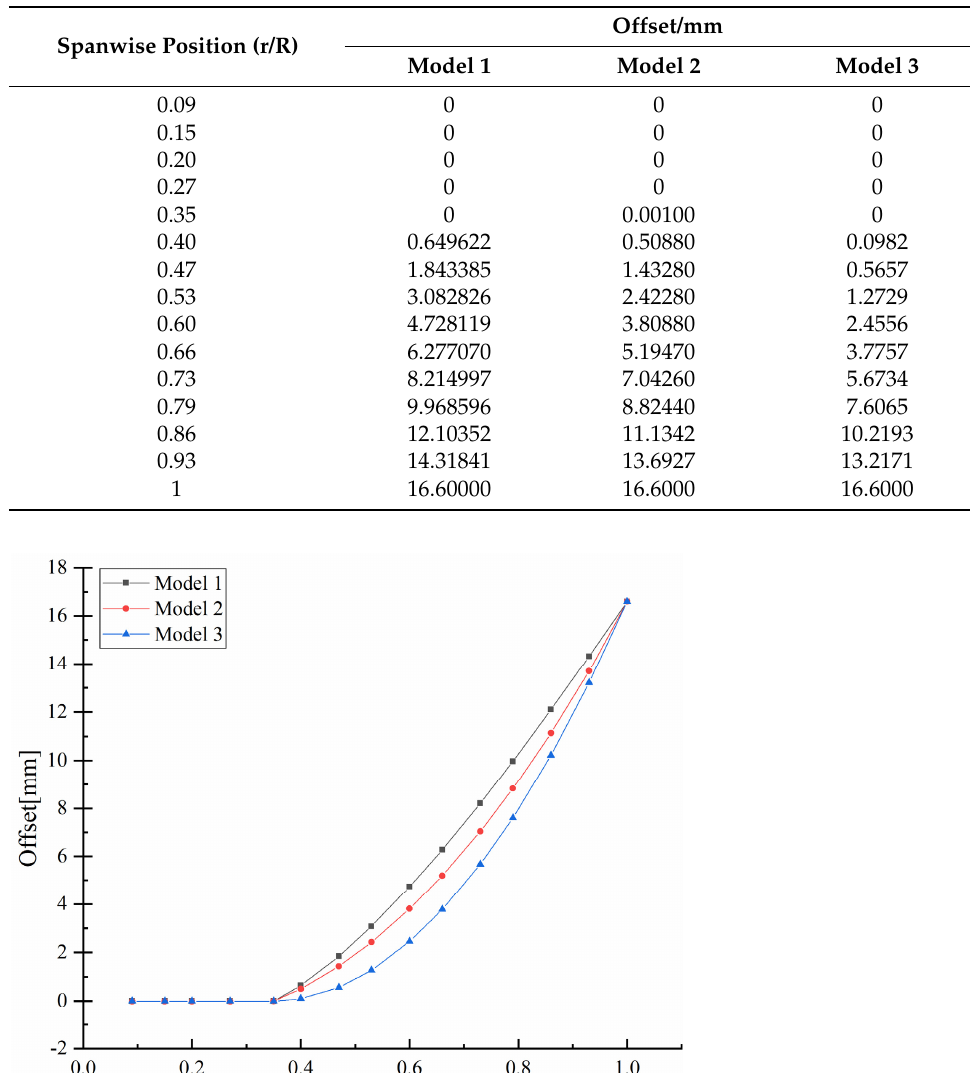
Table 3. Offsets corresponding to different models.